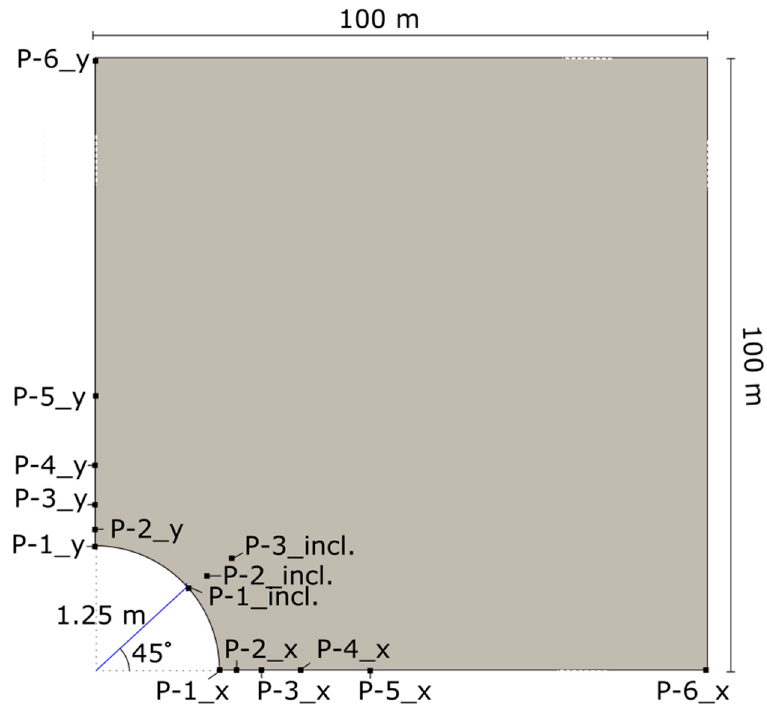
Figure 1. Model geometry (adapted from [11]).